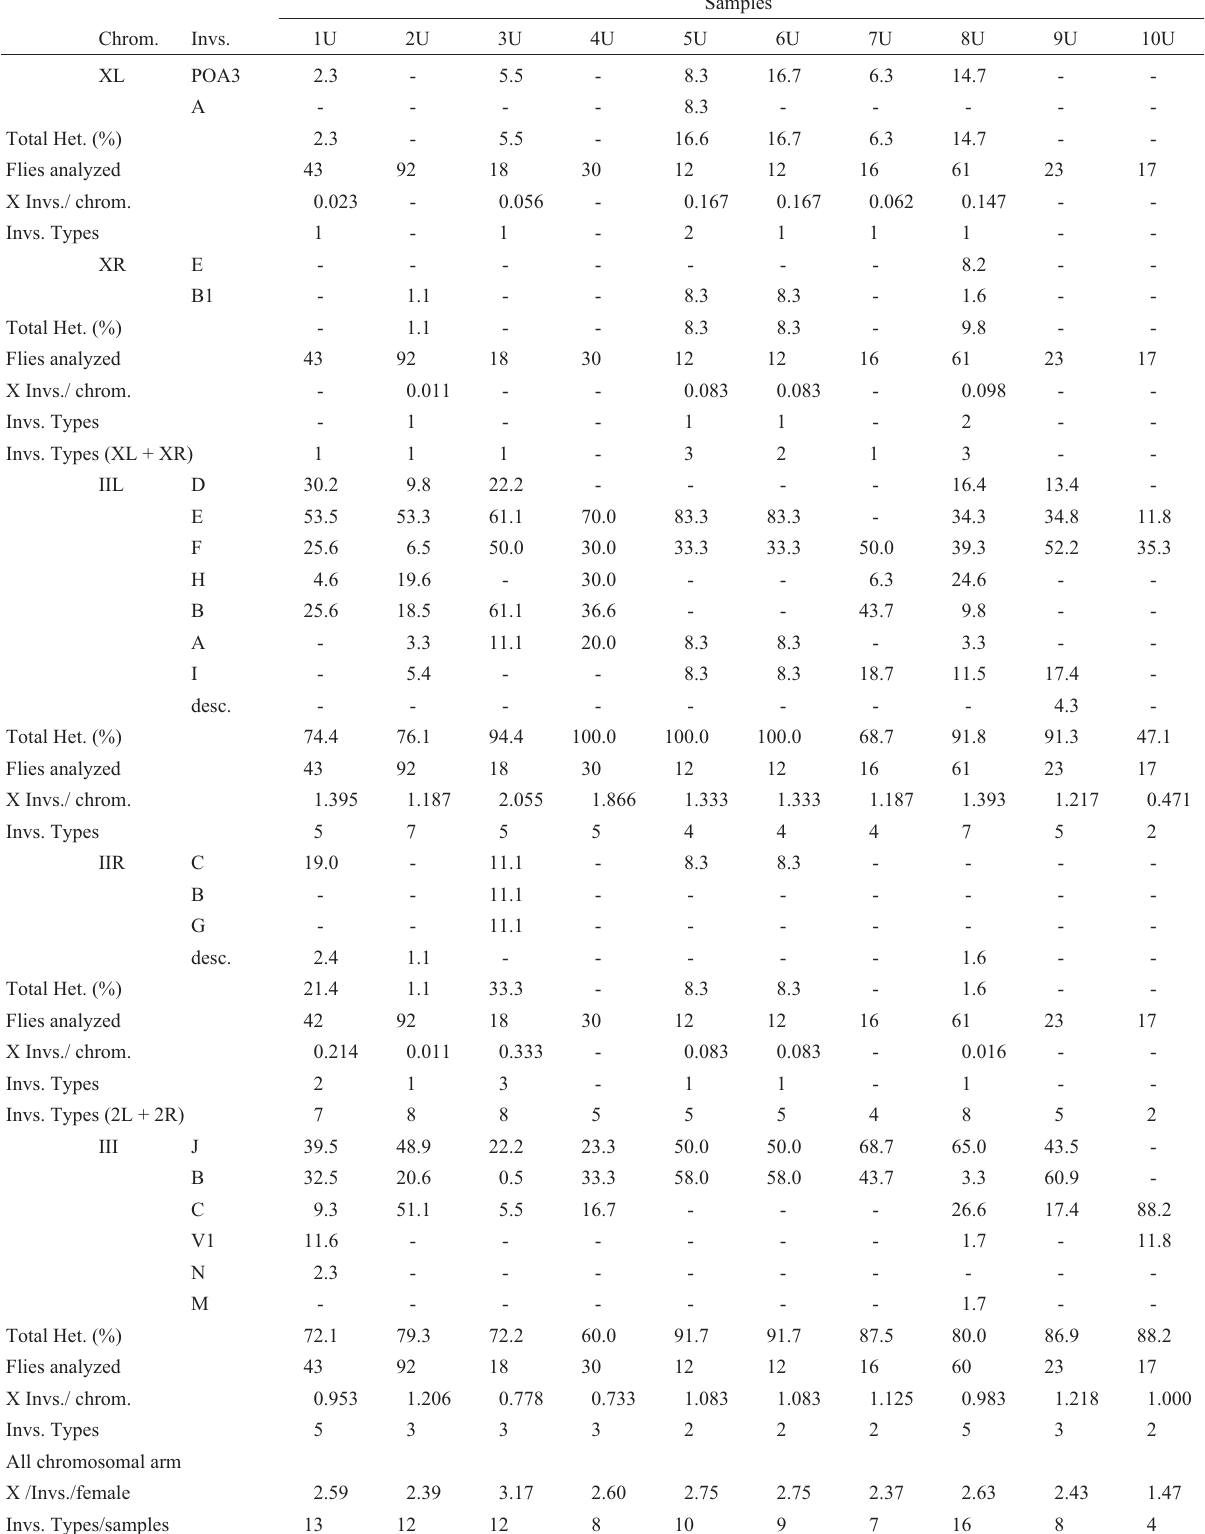
Table 2 - Frequency (%) of inversions, total heterozygosis, and mean number of inversions per chromosome and per female of Drosophila willistoni populations from Uruguay. Percentages above 100 after summation indicate more than one inversion per chromosomal arm.